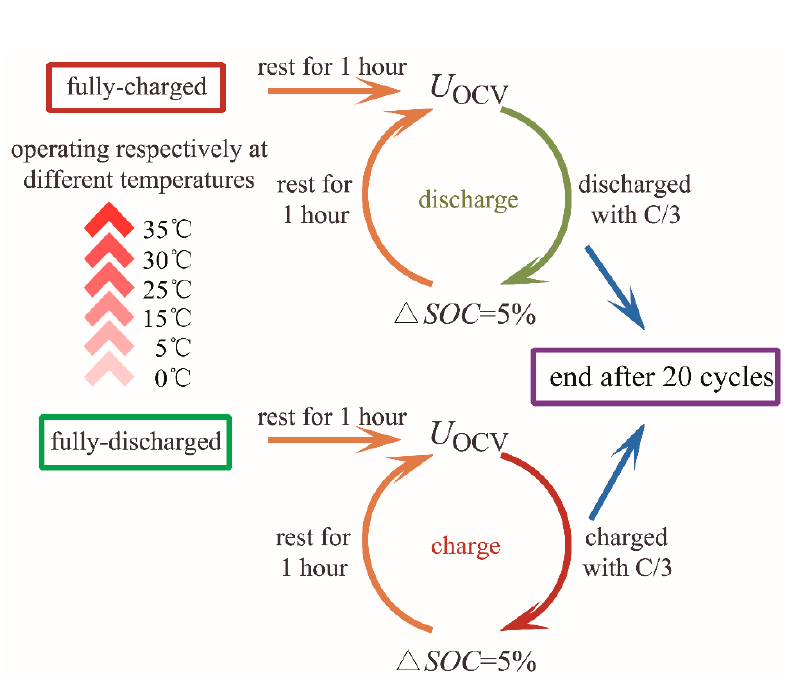
Figure 6. Scheme of discharging–charging open circuit voltage test at different temperatures in the range 0–35 °C.